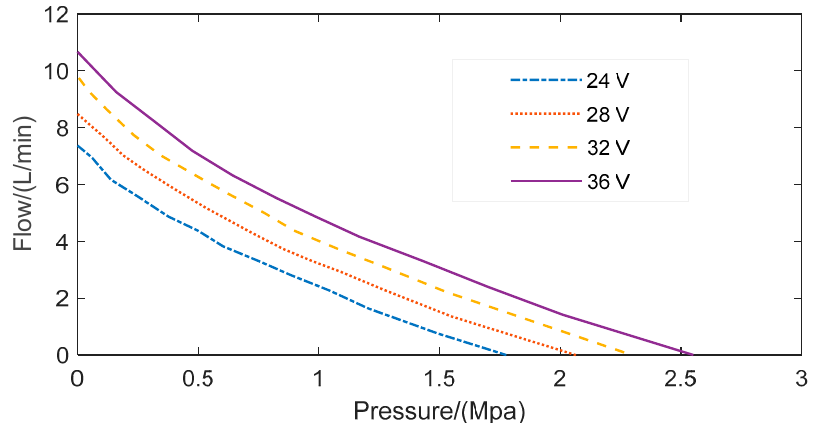
Figure 8. The operating characteristics of the proposed IEHVP.